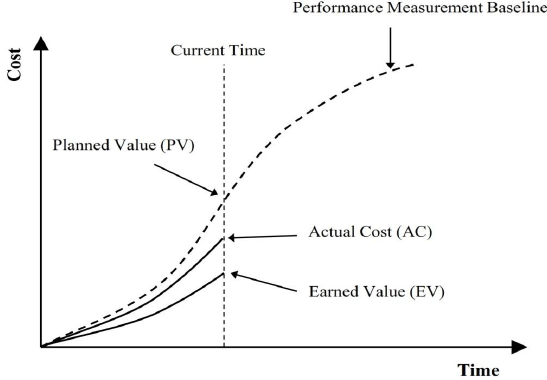
Figure 1. Graphic representation of earned value management (EVM), adopted from PMI [22].